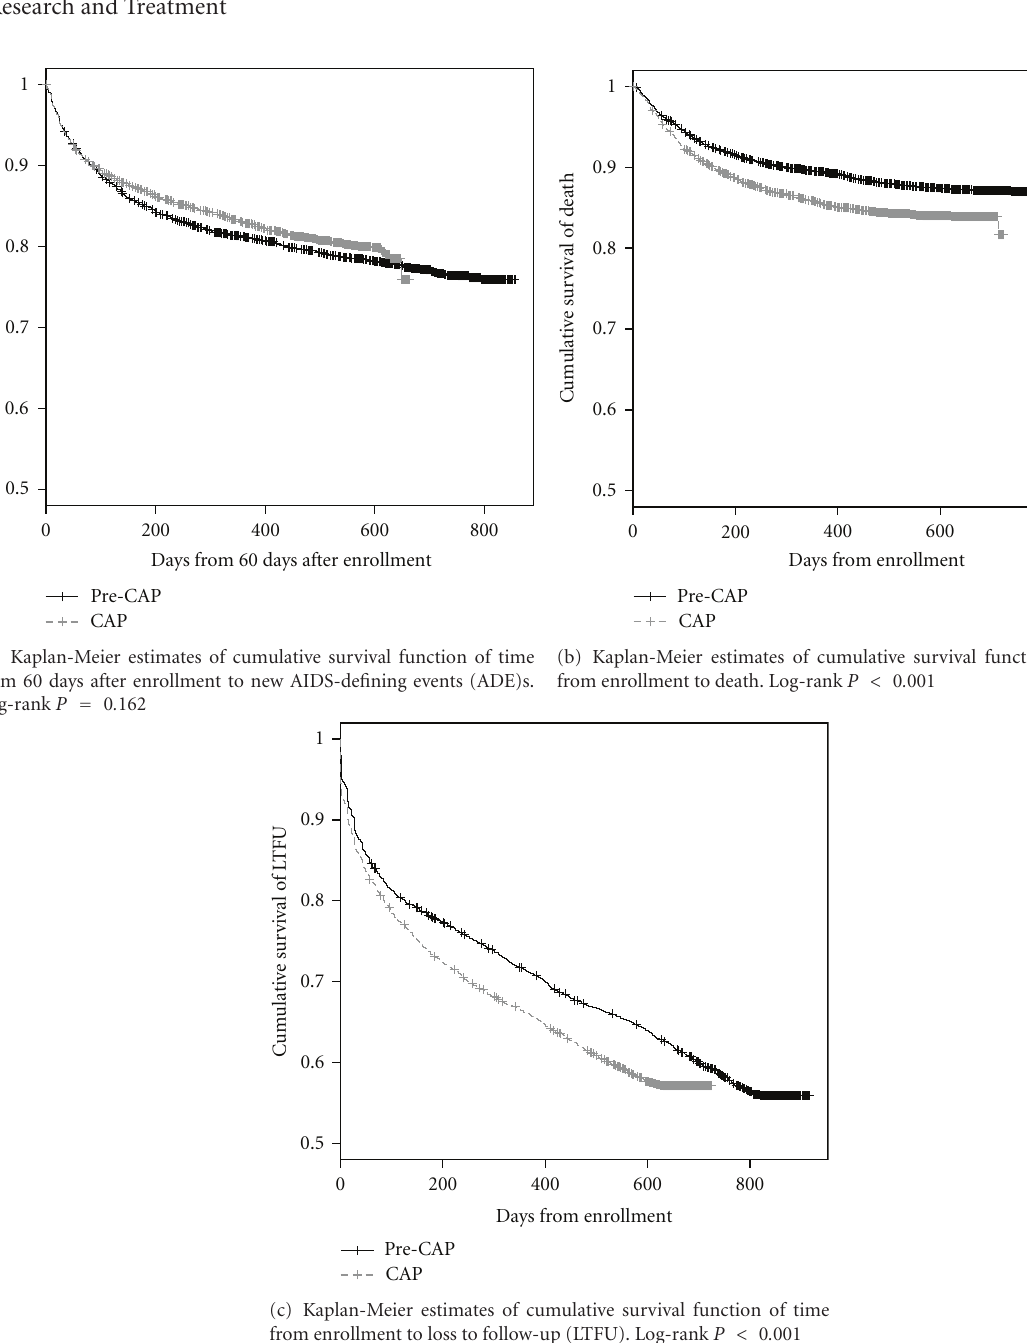
Figure 1: Kaplan-Meier estimates of cumulative survival function of time to (a) new AIDS defining event (ADE); (b) death; (c) loss to